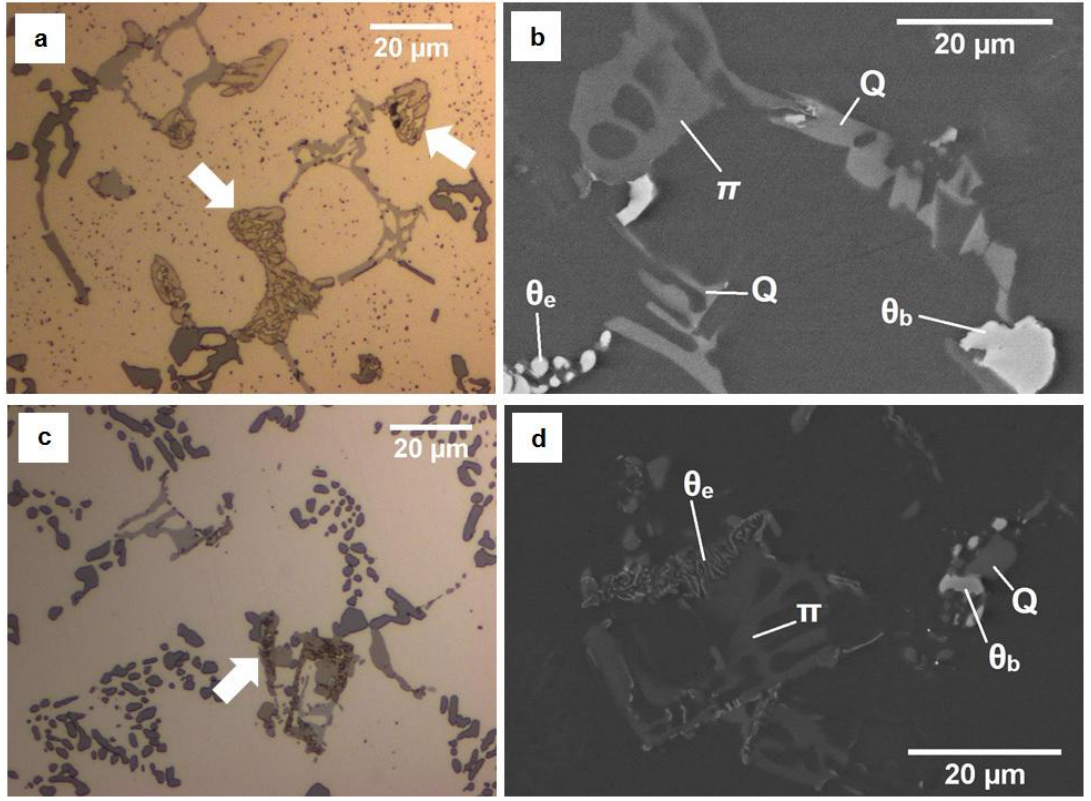
Figure 5. Optical and SEM images of A354 samples solution heat treated at 495 °C for ( a , b ) 2 h and ( c , d ) 6 h, show the different dissolution behavior of eutectic (θ e ) and block-like (θ b ) Al 2 Cu particles; partially readapted from Reference [21].